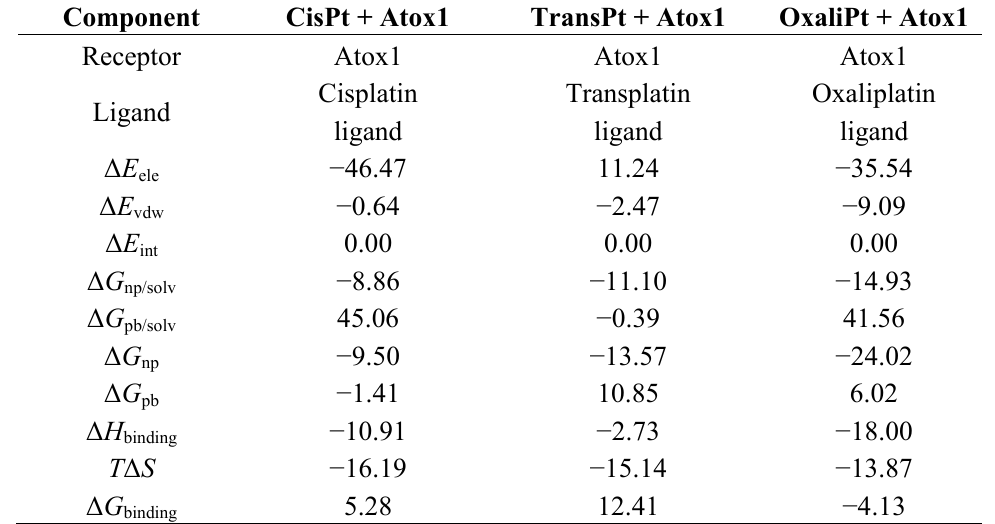
Table 1. Molecular mechanics Poisson–Boltzmann surface area (MM-PBSA) free energy components (kcal·mol − 1 ) for non-covalent interaction in the CisPt + Atox1, TransPt + Atox1 and OxaliPt + Atox1